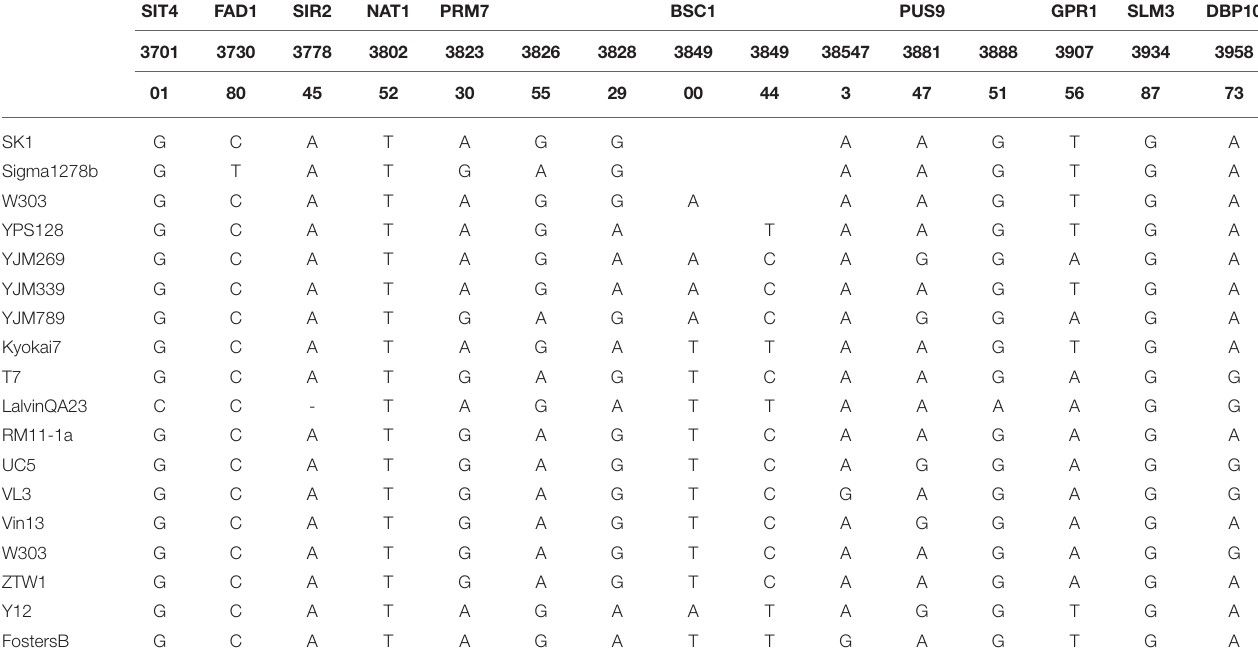
TABLE 3 | The candidate genes were selected according to their function and non-synonymous SNPs in the parental strain sequences. Gene Function Changes in protein sequence BRE1 E3 ubiquitin-protein ligase, involved in double strand break repair, histone ubiquitination,